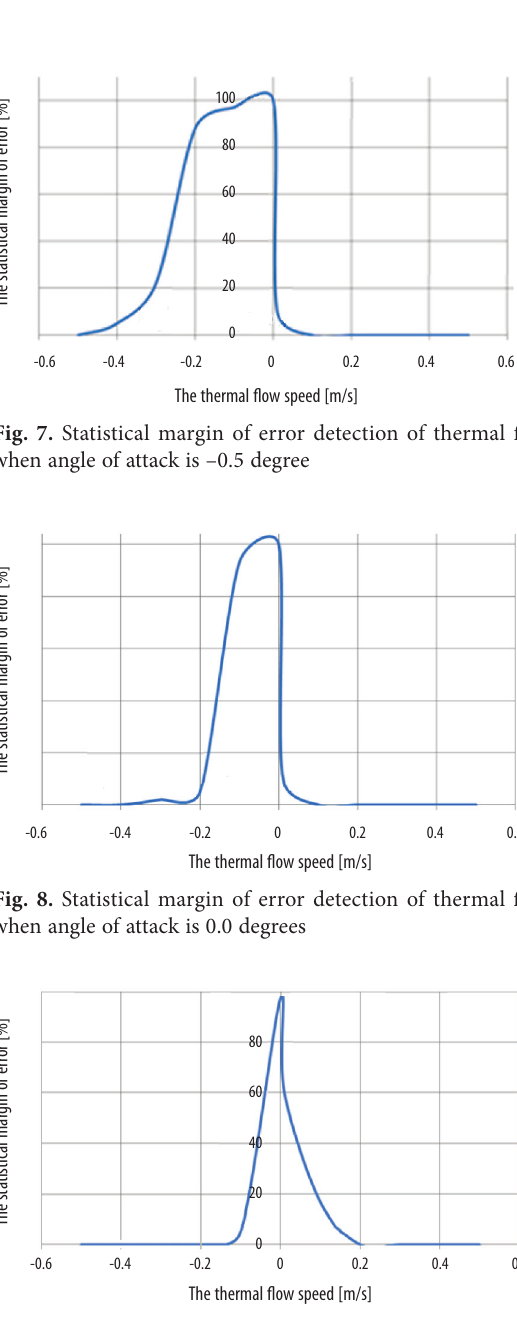
Fig. 9. Statistical margin of error detection of thermal flow, when the angle of attack is 1.0 degree